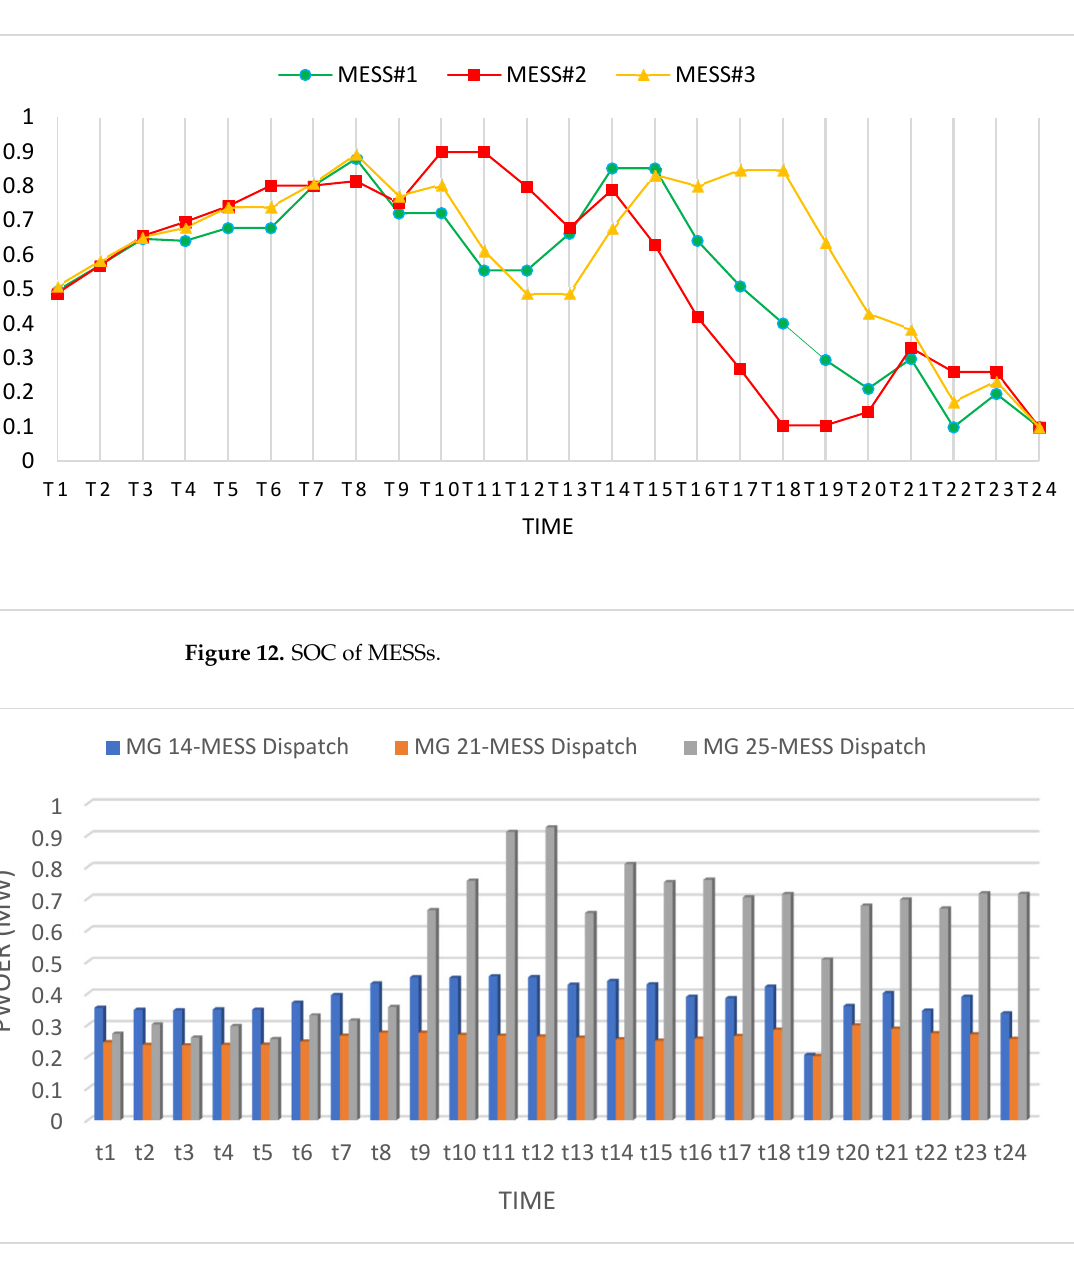
Figure 13. Power balance at each MG.